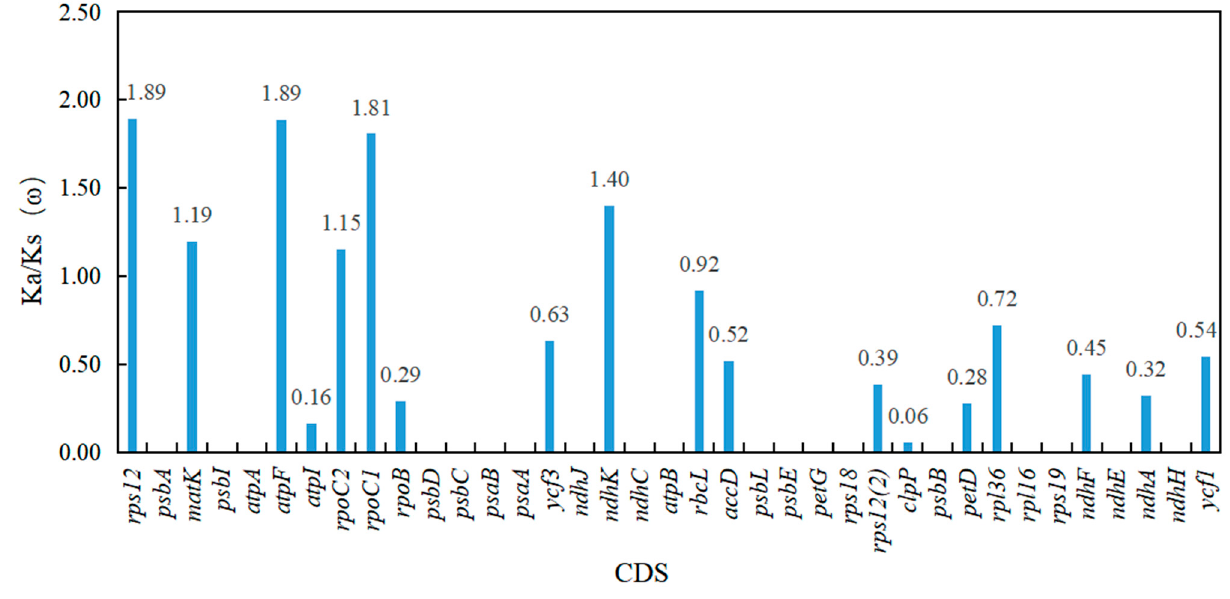
Figure 4. The Ka/Ks ( ω ) values of 37 shared functional protein-coding genes of 16 chloroplast genomes of Quercus section Cyclobalanopsis .